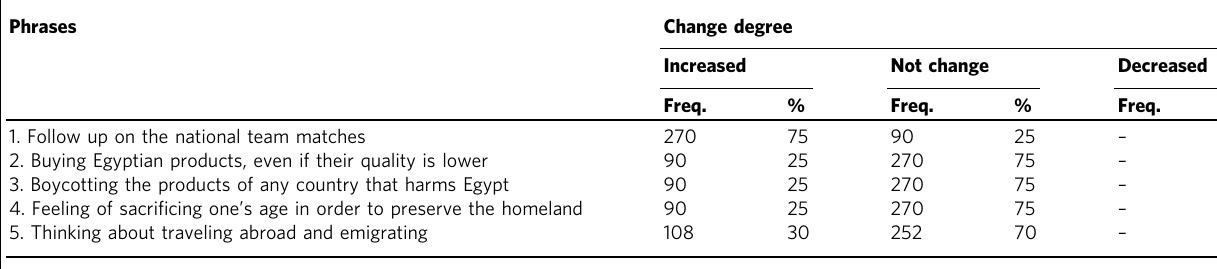
Table 5 Respondents ’ responses according to the change in the cultural identity component of Af fi liation.